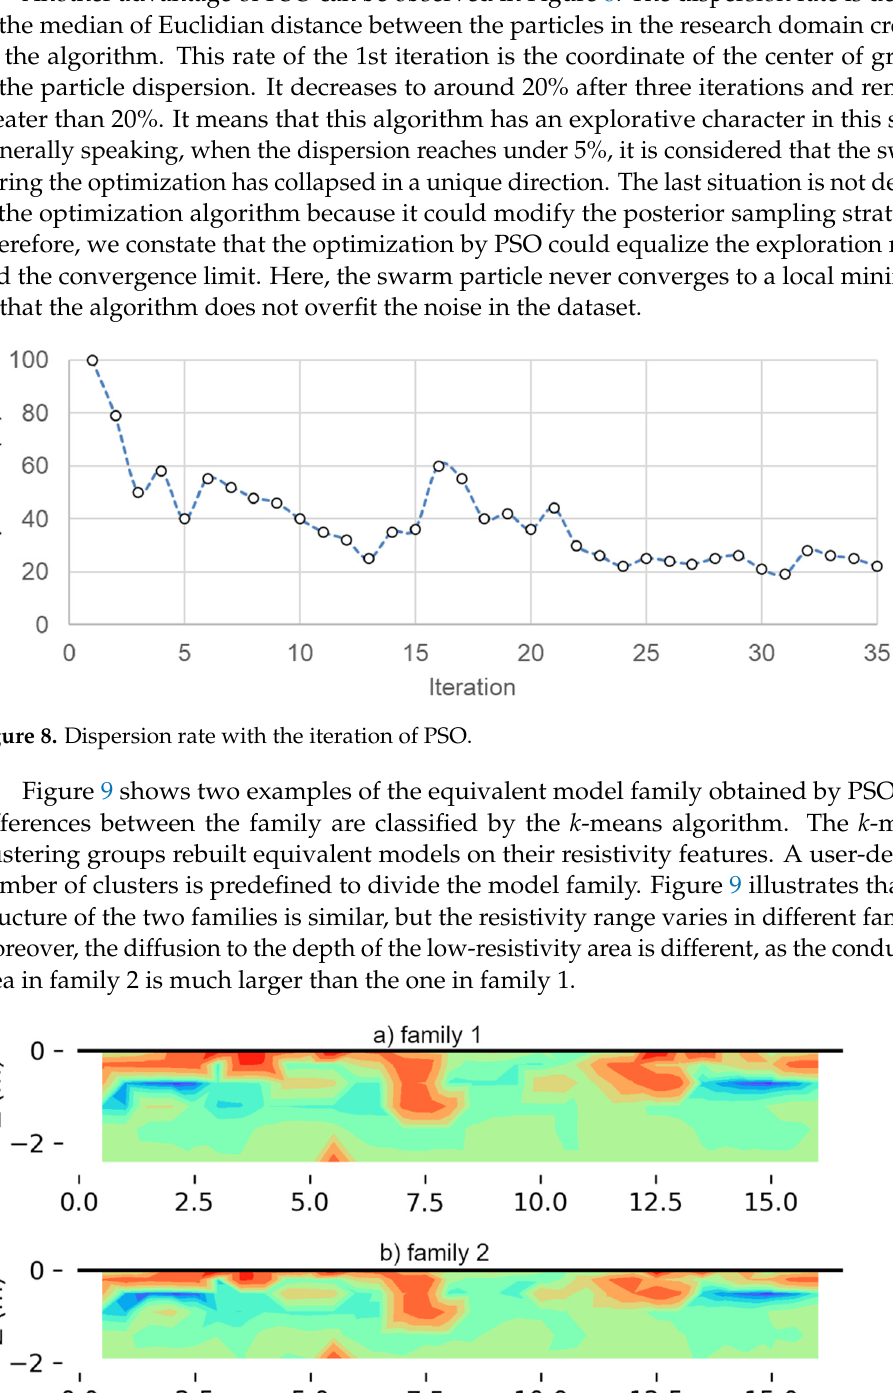
Figure 9. Example of two different clusters of equivalent models obtained by k -means clustering. ( a ) family 1 from the 1st cluster; ( b ) family 2 from another cluster of the equivalent models.